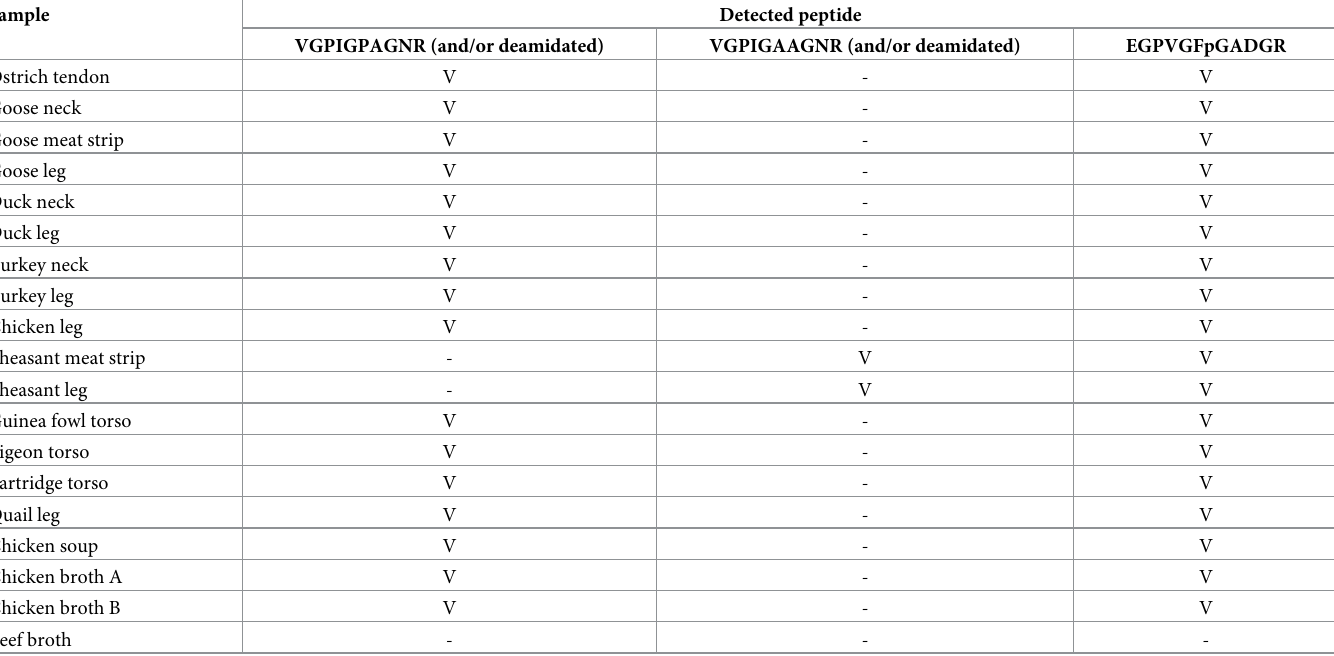
Table 3. Results of the experimental assessment of generic bird peptides. The presence of VGPIGPAGNR / VGPIGAAGNR (and/or deamidated) and EGPVGF p- GADGR in several bird samples and negative control beef broth is